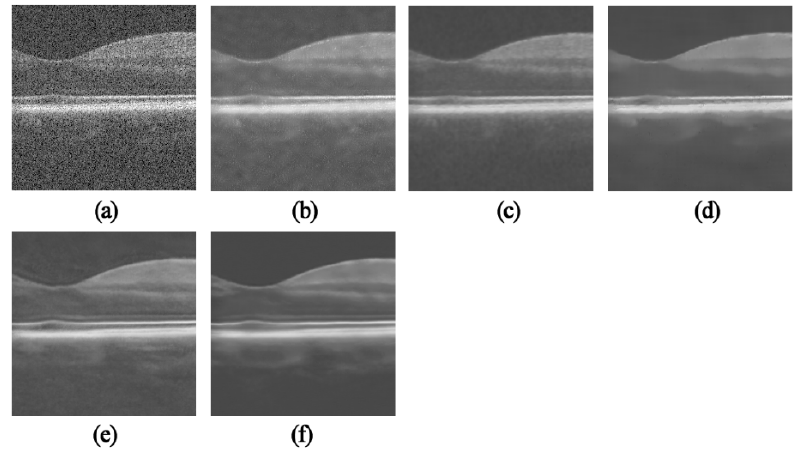
Figure 6. Comparison of local layered structures of the green box in Figure 3. ( a ) Noisy image (256 × 256), results by ( b ) TNode, ( c ) SBSDI, ( d ) PNLM, ( e ) DIP, ( f )